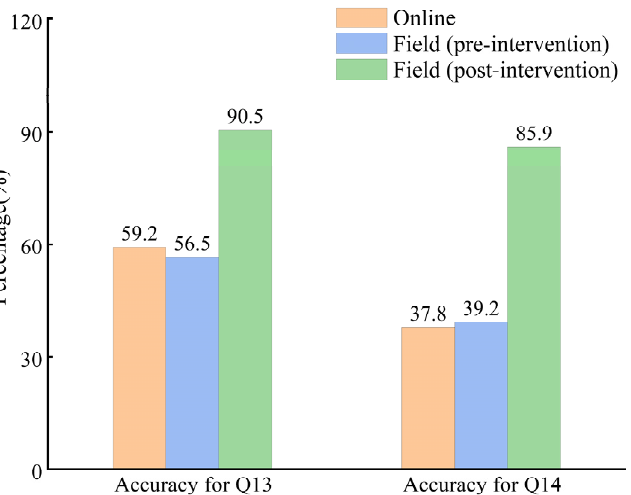
Figure 8. Comparison of the overall accuracy of online and field respondents in identifying rip current and choosing escape direction, as well as the accuracy after implementing educational strategy.